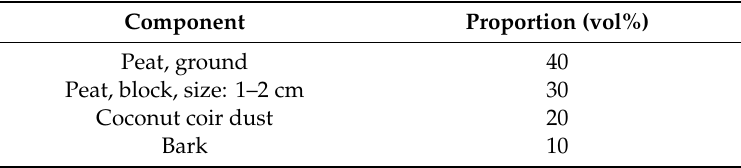
Table 2. Composition of the dry soil mixture.